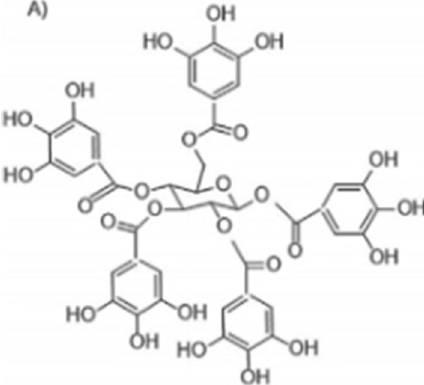
Fig. 1 Structure of a simple gallotannin. Source: [30]